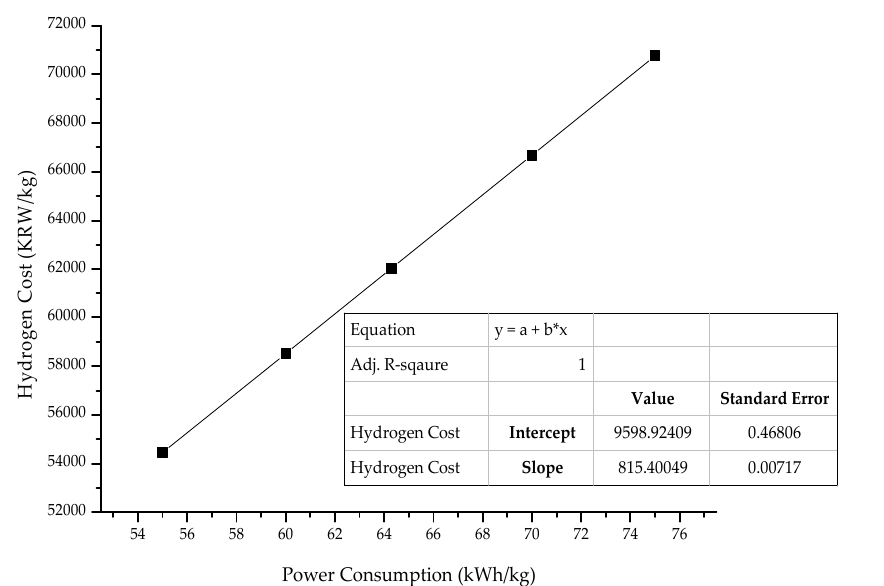
Figure 8. Correlation between power consumption for producing hydrogen and hydrogen cost *. * x -axis: Power Consumption (kWh/kg), y -axis: Hydrogen Cost (KRW/kg). Solid line: y-values connecting line, Dot line: Regression line.